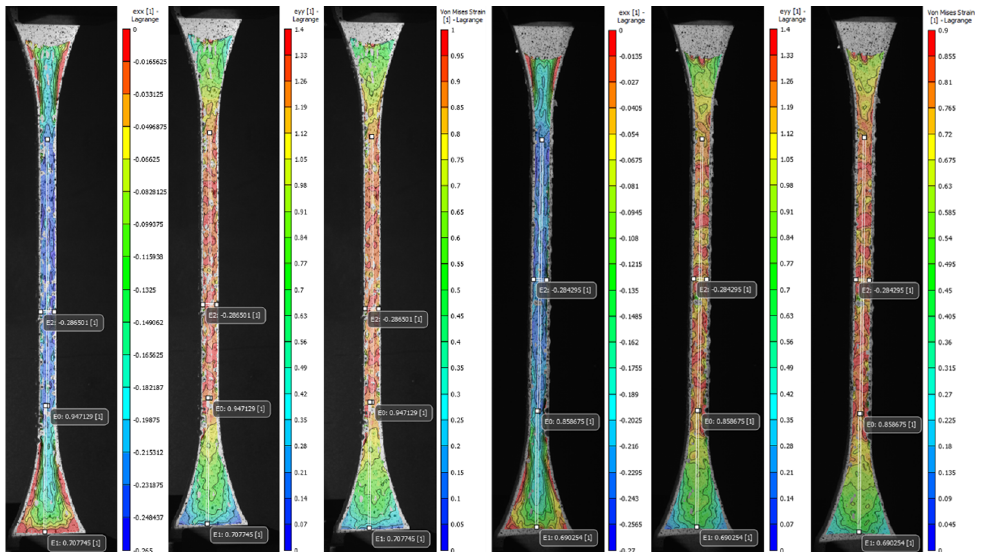
Figure 14. Digital image correlation (DIC) strain fields of the most significant specimens. A1 Bamboo-Like (BL)—C Tendon-Like (TL). Longitudinal strain (e yy ), local transverse strain (e xx ), and Von Mises equivalent strain (e eq ). The virtual longitudinal extensometers E 0 and E 1 are positioned at L 0 = 33 mm (narrow section) and L = 16 mm (distal). Transverse extensometer E 2 is positioned at 𝐿 = 6 mm (central).